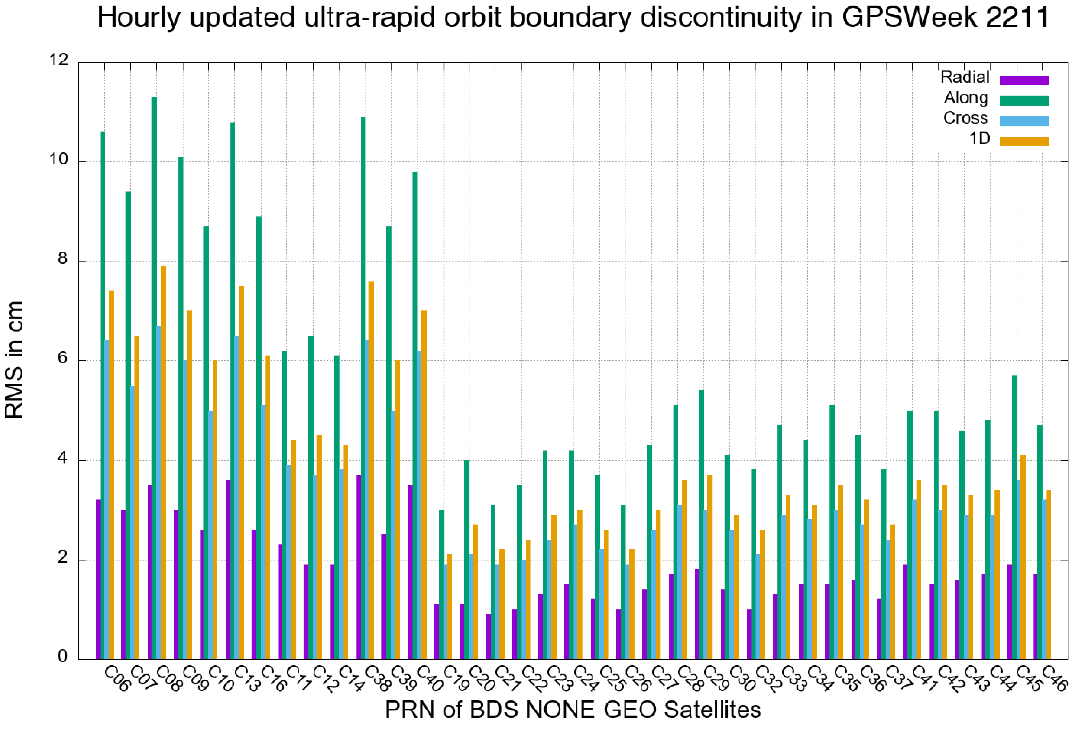
Figure 16. Mean RMS of overlapping in the RAC components and 1-D of BDS NONE GEO satellites.